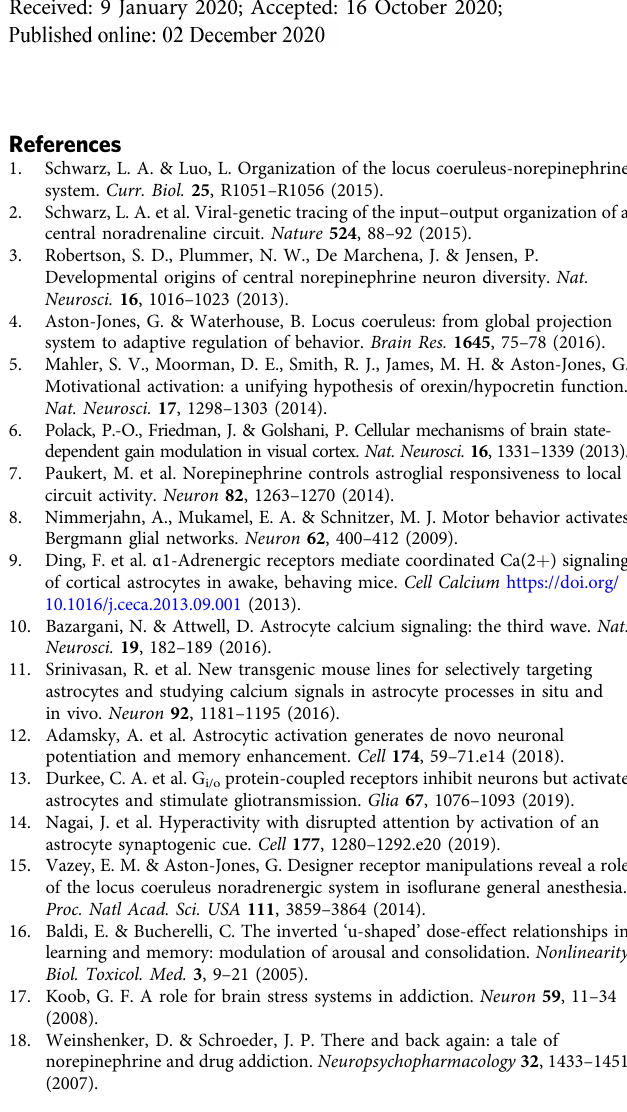
Fig. 10e we used https://www.mathworks.com/matlabcentral/ fi leexchange/27080- mixed-between-within-subjects-anova. The basis of the sample number for indi- vidual tests and respective test type applied are mentioned in the results section, usually the respective fi gure legend. The signi fi cance of test results is indicated by p values in the graphs or by the abbreviation n.s. for not signi fi cant when p ≥ 0.05. Reporting summary . Further information on research design is available in the Nature Research Reporting Summary linked to this